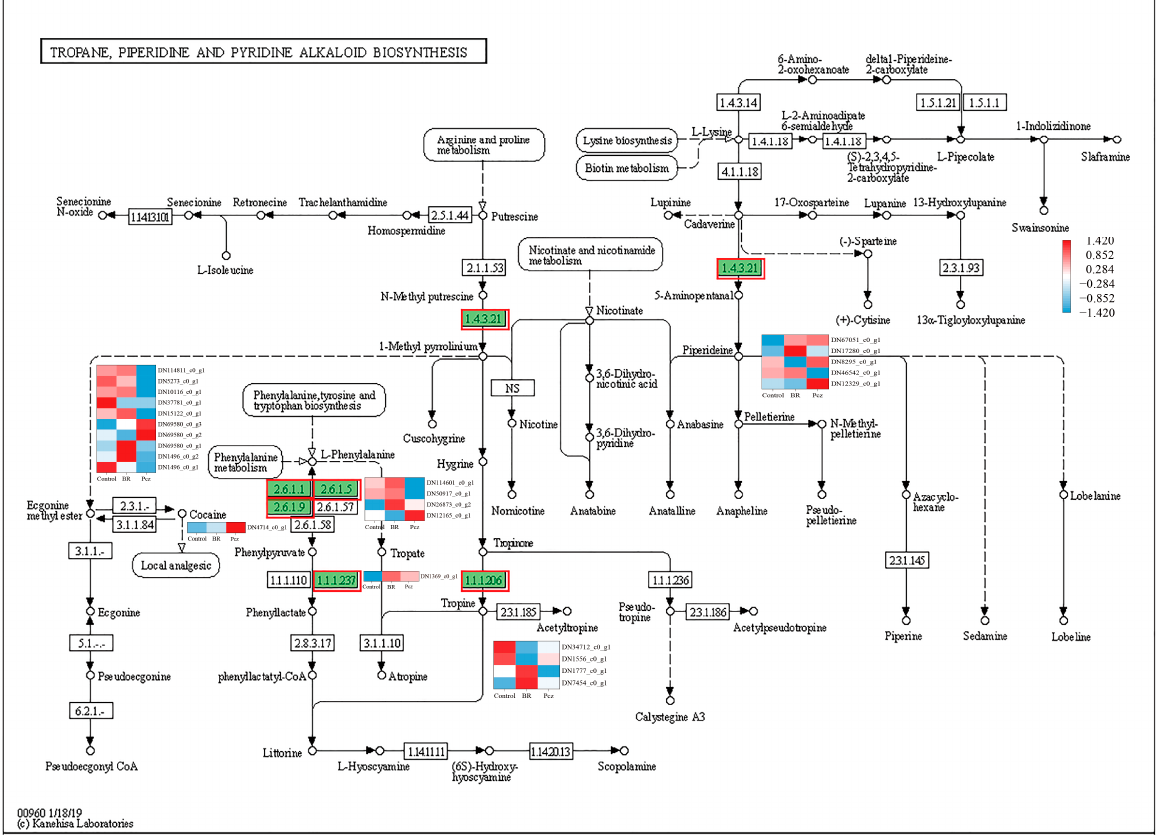
Figure 4. Differential expression levels of unigenes related to tropane, piperidine, and pyridine alkaloid biosynthesis identified by KEGG annotation. Changes in expression level are represented by a change in color; blue indicates a lower expression level, whereas red indicates a higher expression level. All data shown reflect the average mean of three biological replicates.